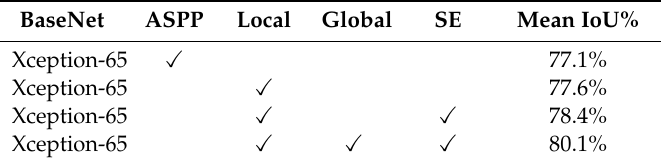
Table 1. Performance evaluation on Cityscapes val. set.